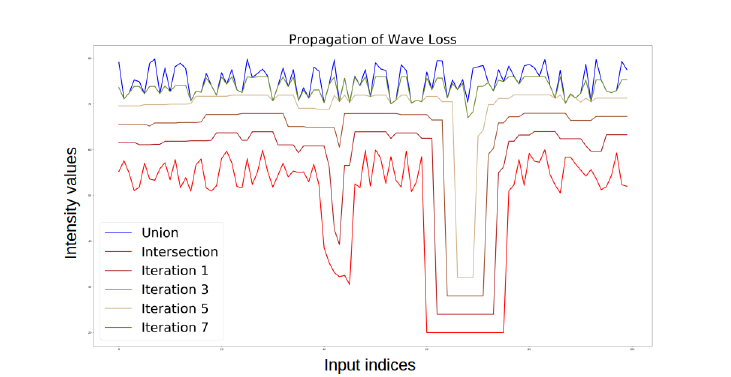
Figure 4. The propagation of the wave during the calculation of wave